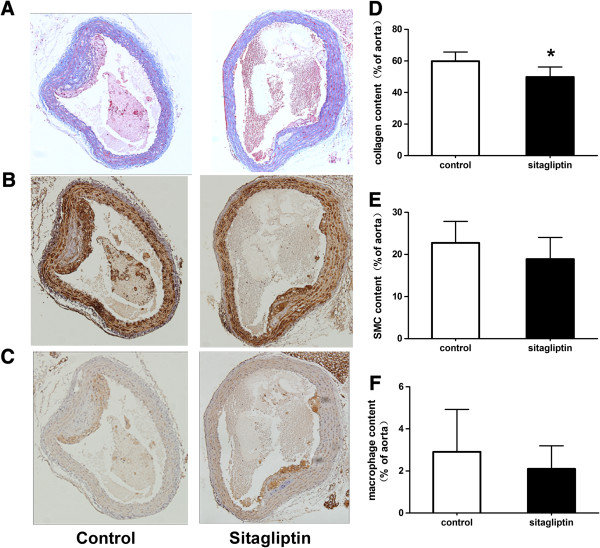
Effects of sitagliptin on collagen fibers, macrophages, and smooth muscle cells in atherosclerotic lesions. Cross-sections of the aortic root were cut into slices and stained with Masson (A), anti-smooth muscle cell (B), and anti-macrophage antibody (C). The ratios occupied by collagen fibers (D), smooth muscle cells (E), and macrophages (F) in the aortic plaque were also evaluated. Values are mean ± SD; n = 6 per group; *p < 0.05.